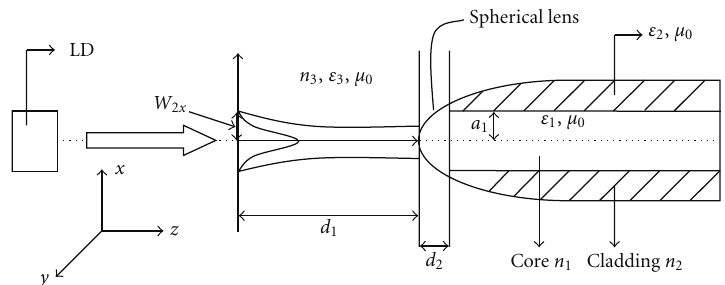
Figure 1: Schematic diagram of laser diode to optical fibre coupling configuration via